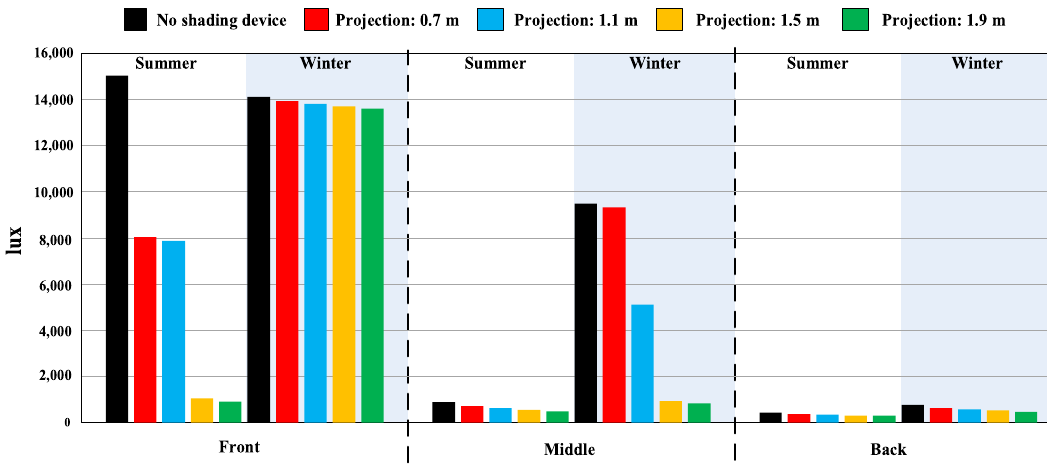
Figure 5. Daylighting performance through the overhang-shaped louver.